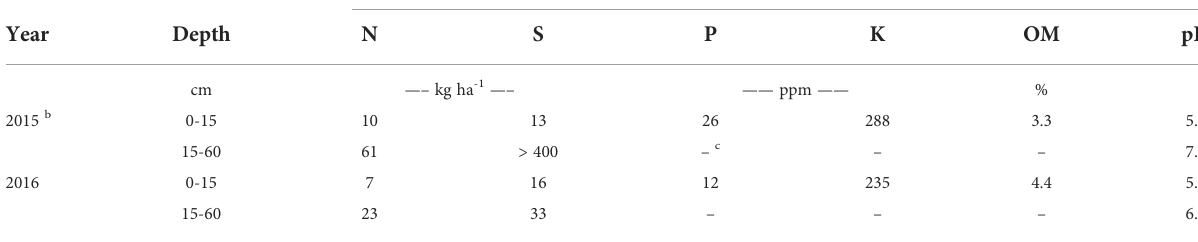
TABLE 1 Soil nutrient status, organic matter and pH for each year of the